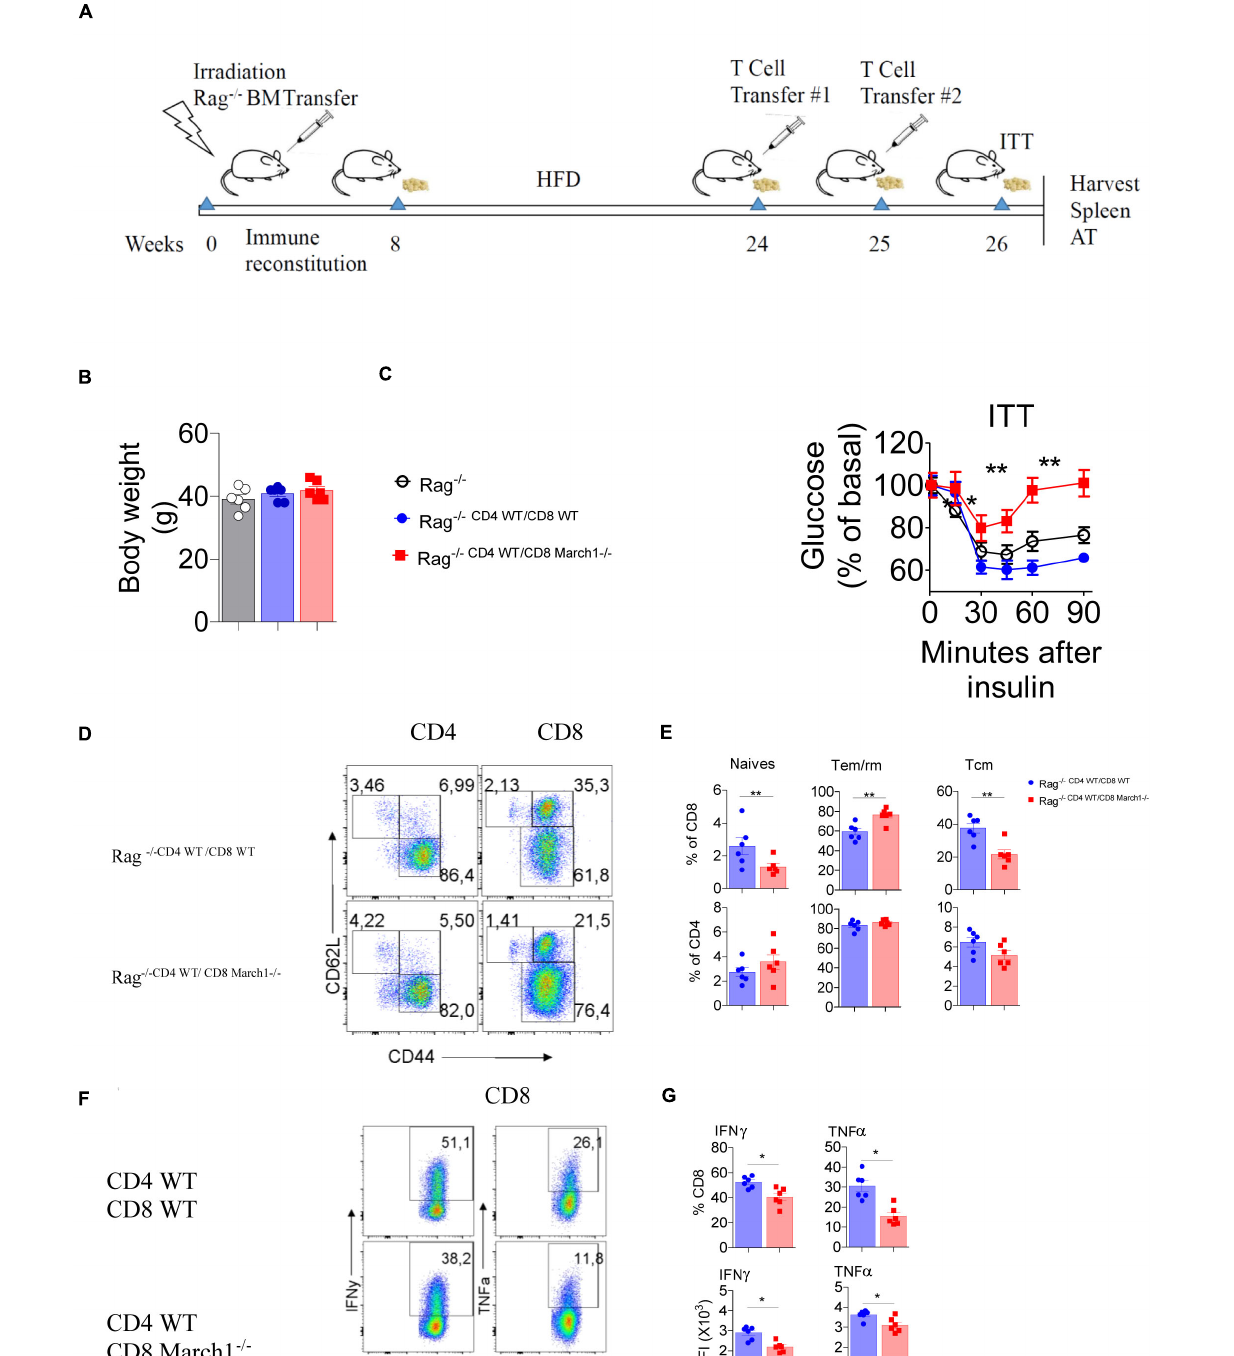
Frontiers in Immunology |